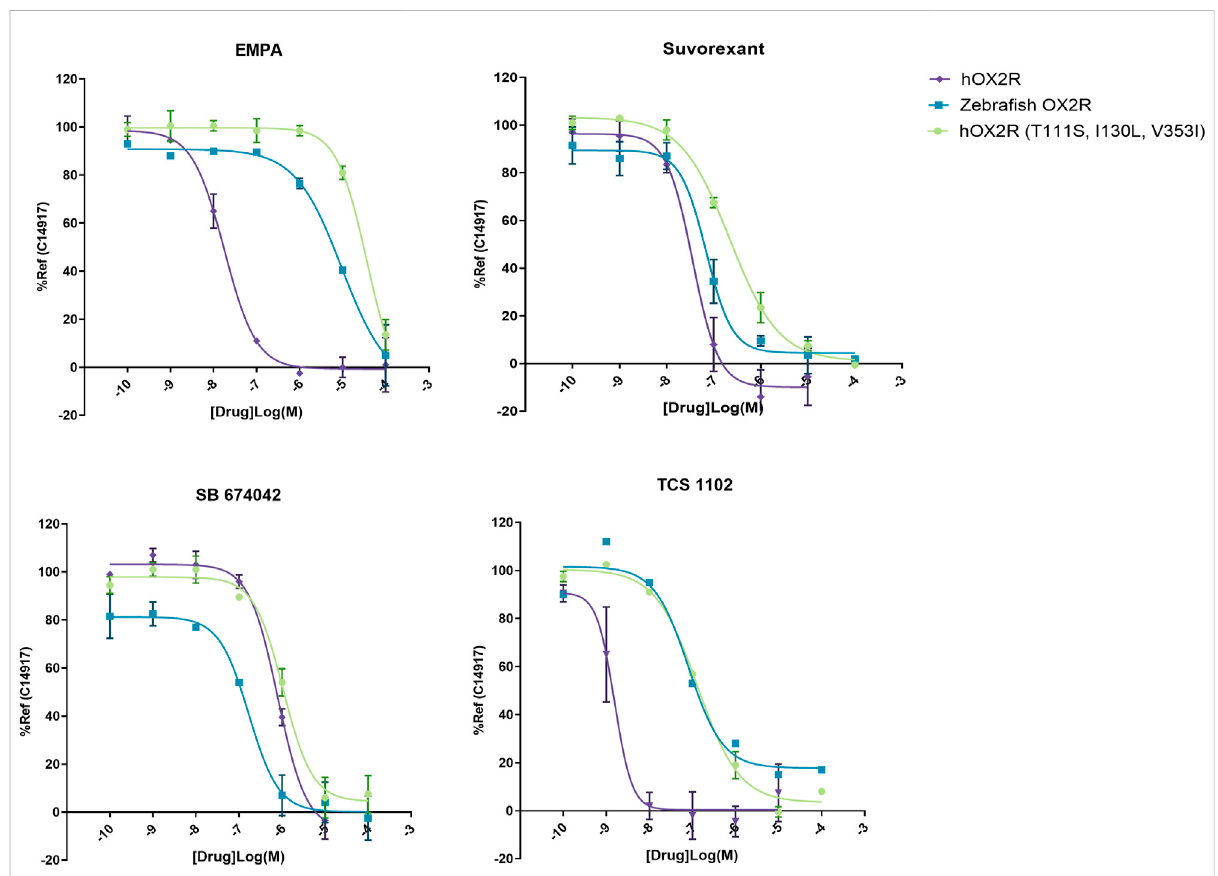
FIGURE 2 Representative IP-One dose response curves for antagonists EMPA, Suvorexant, SB 674042 and TCS 1102 on human OX2R (purple), zebra fi sh OX2R(blue)andhOX2R(T111S,I130L,V353I)(green).Antagonistswereincubatedfor 30 minat37 ° Candsubsequently thecellswerestimulated with 1 µM of reference agonist C14917. Cells were incubated for 2 more hours and subsequently readout was performed. Dose responses were performed as technical duplicates, data were normalized to 10 µM of reference agonist C14917.